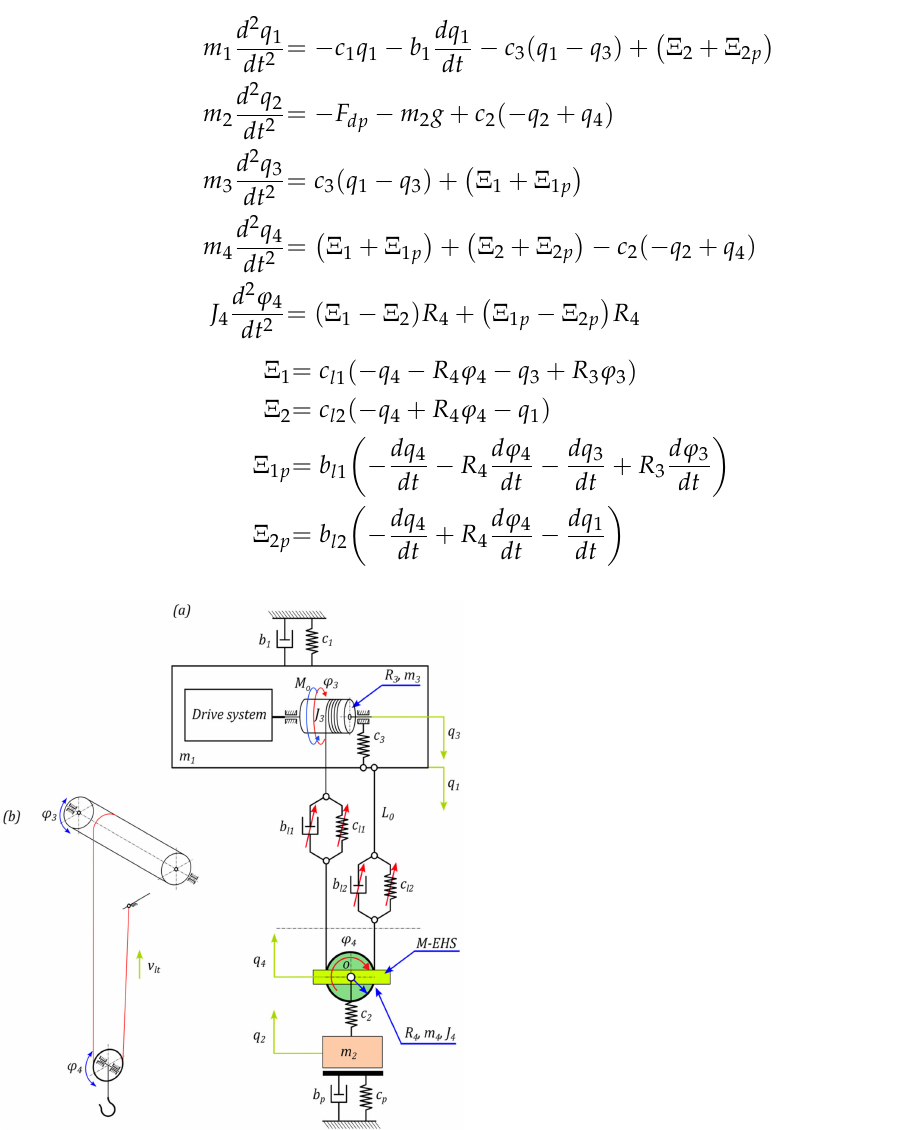
Figure 5. ( a ) An extended model of the hoisting system with the drive system and ( b ) a simplified rigging system without equalizing the